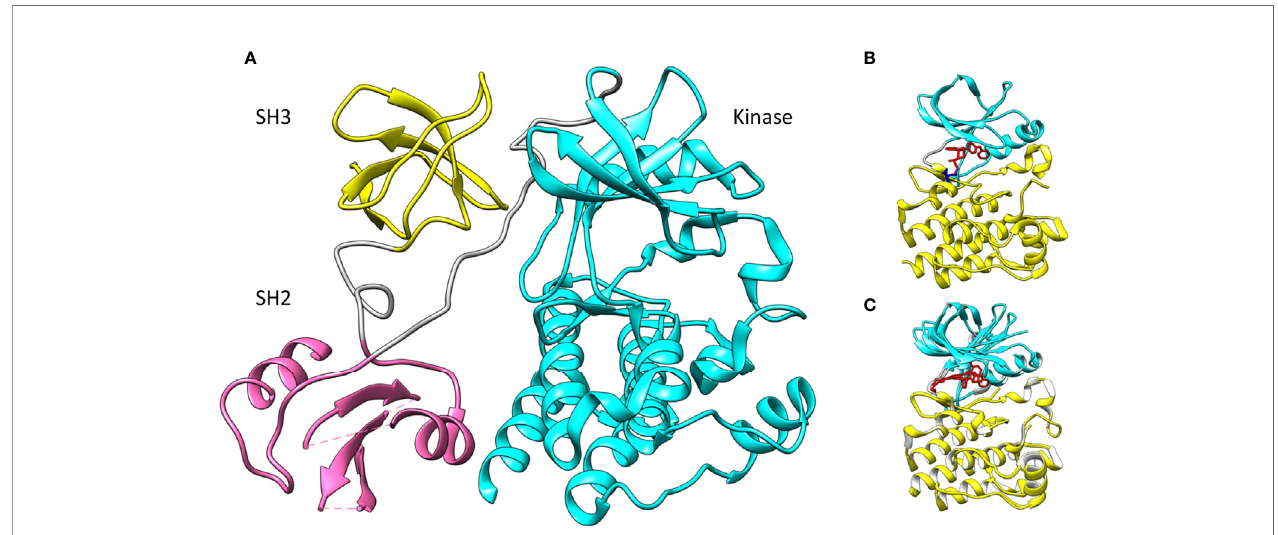
FIGURE 1 | (A) Spatial organization of mouse BTK SH3 (yellow), SH2 (pink) and kinase domains (cyan). Linkers are in gray. The SH2 and SH3 domains are indicated by their positions in the dimer (PDB id 4xi2). (B) Human BTK kinase domain with ibrutinib (red) bound covalently (magenta) to C481 (blue) (5p9j). The upper lobe is in cyan, the lower lobe in yellow and inhibitor in red. (C) Superimposition of closed (5p9j) and open BTK kinase conformation (1k2p). Upper lobe is in cyan and lower lobe in yellow. Lower lobe was used for the